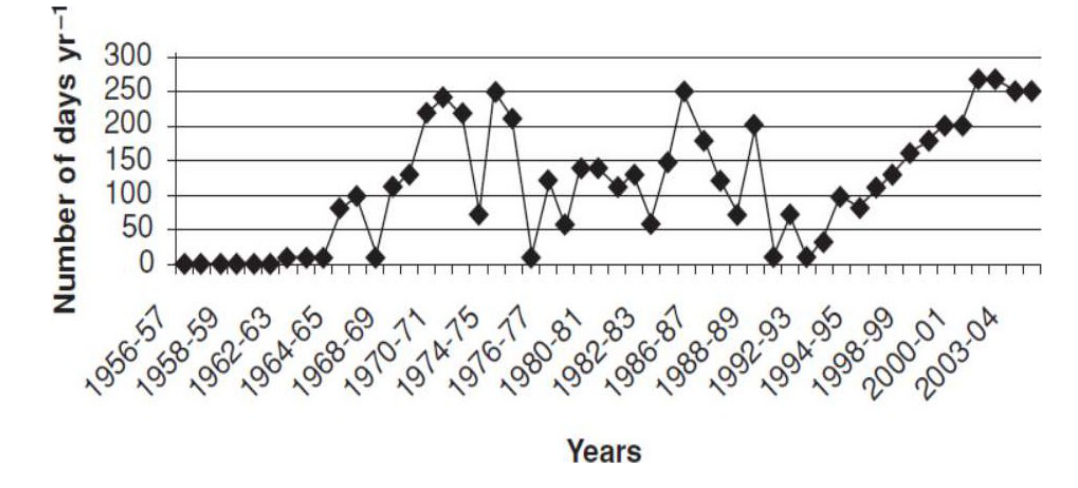
FIG. 8. ZERO FLOW DAYS BELOW KOTRI BARRAGE DOWNSTREAM (SOURCE: INAM ET AL.